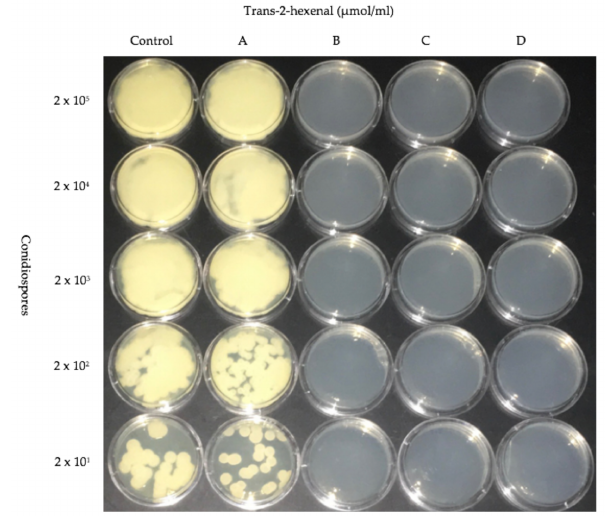
Figure 6. Dilution assay of five different concentrations of P. destructans conidiospores treated with trans -2-hexenal. Vapors of VOC as follows: ( A ) 0.005 µ mol/mL; ( B ) 0.01 µ mol/mL; ( C ) 0.02 µ mol/mL; ( D ) 0.05 µ